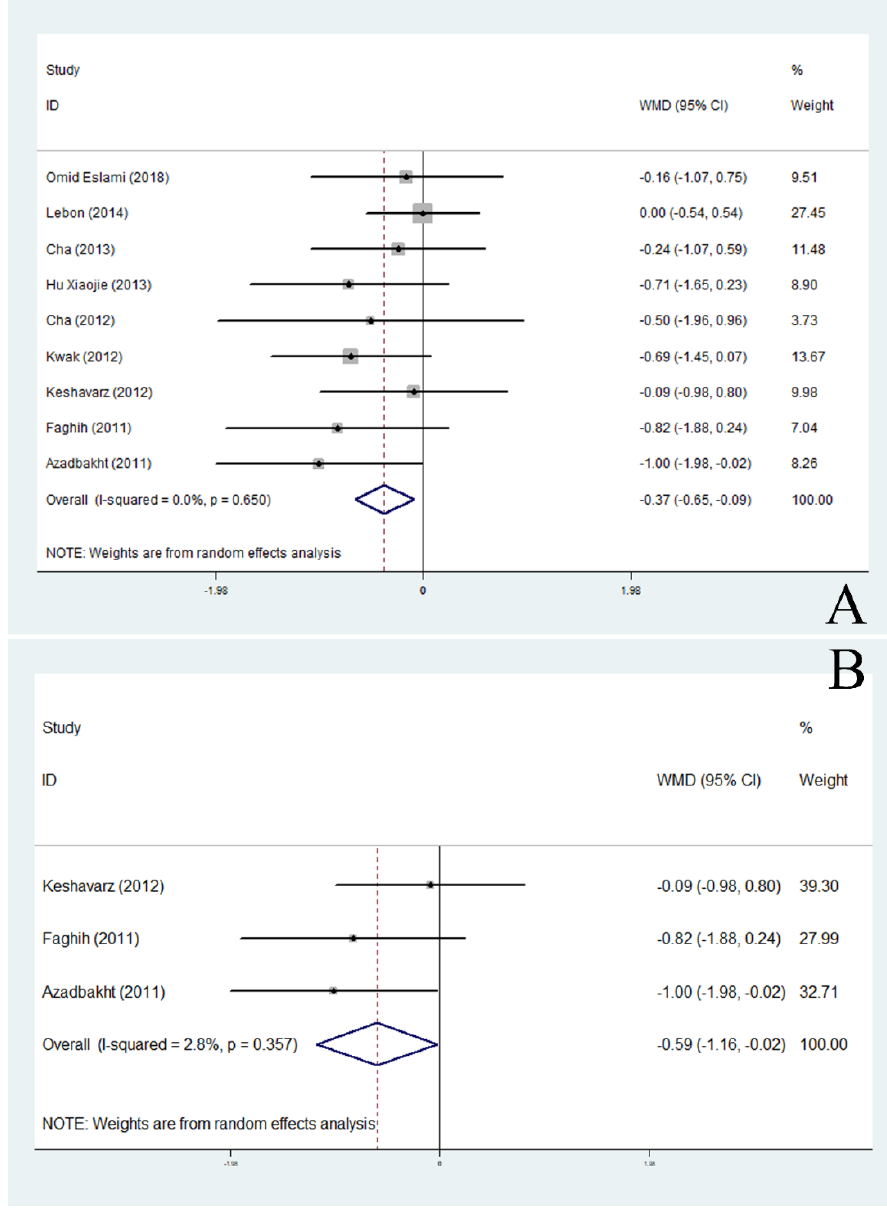
Figure 3. Meta-analysis of the effect of soy products on body weight in Asian population ( A ) and non- menopausal ( B ). ID: identification; WMD: weighted mean difference. non-menopausal ( B ). ID: identification; WMD: weighted mean di ff